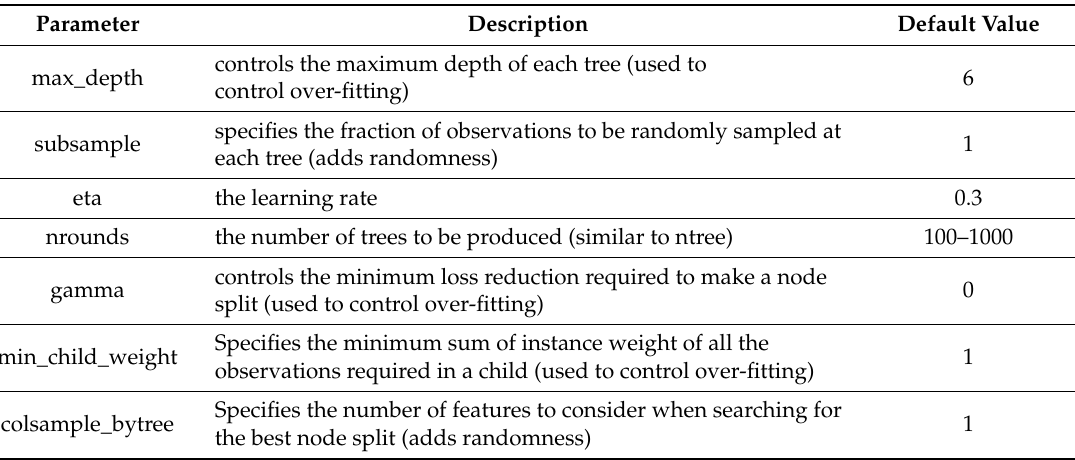
Table 1. Key parameters used for XGBoost